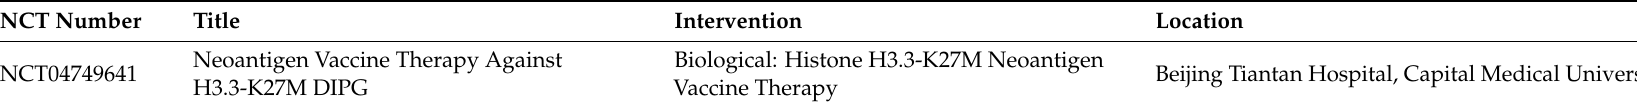
Table 4. Active clinical trials for children with diffuse intrinsic pontine glioma involving immunotherapeutic options as found on www.Clinicaltrials.gov as of 12 January